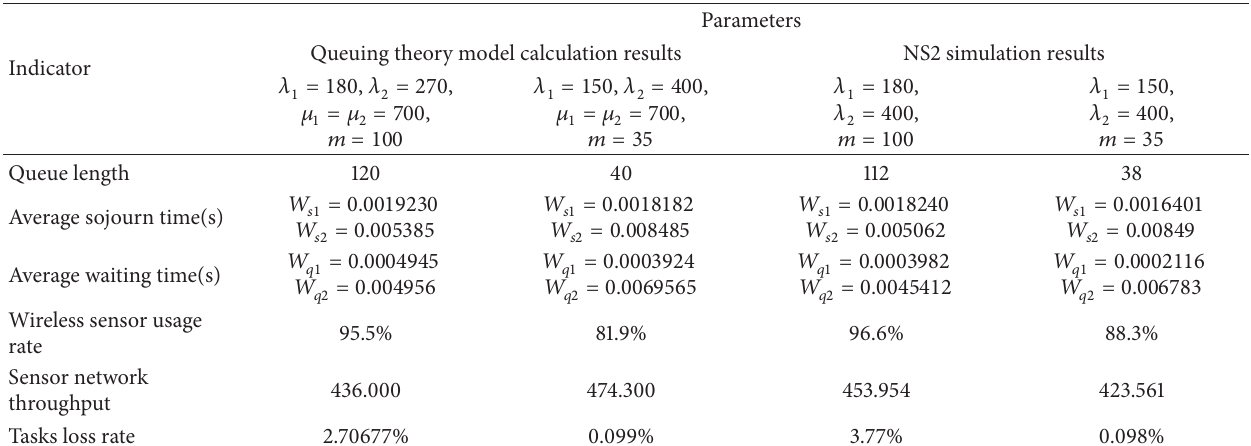
Table 3: Experimental data